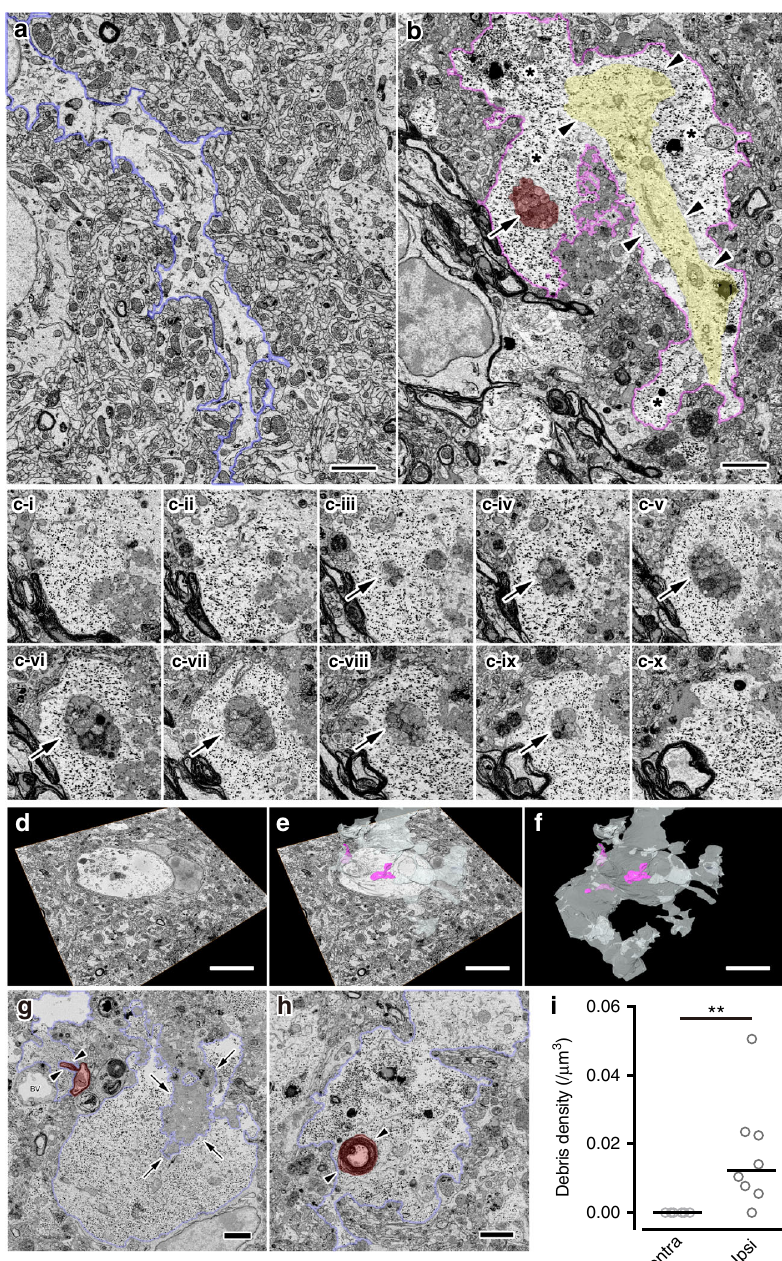
Fig. 2 Phagocytosis of cellular debris by reactive astrocytes in the ischemic penumbra. a – c Compared with astrocyte processes in the contralateral striatum ( a , blue ), those in the ischemic penumbra were characterized by prominent intermediate fi lament bundles ( b , yellow, arrowheads ) and abundant glycogen granules ( b , asterisks ), and often contained small pieces of cellular debris ( b , red, arrow ). The debris was completely included in the astrocytic cytoplasm (c- i – c-x, arrows ). d – f Three-dimensional reconstruction shows several pieces of debris ( e , f , pink ) are scattered within single processes ( e , f , white ). g , h Astrocyte processes surround blood vessels ( g , BV), and engulf large debris ( g , arrows ) and myelin debris ( g , h , red , arrowheads ). Bars: 2 μ m a , b , g , h or 5 μ m d – f . i Dot plots of debris density (number/volume ( µ m 3 )) in astrocytes in the contralateral and ipsilateral striatum ( n = 5, eight cells, three mice. ** P < 0.01 vs. control, Mann – Whitney U-